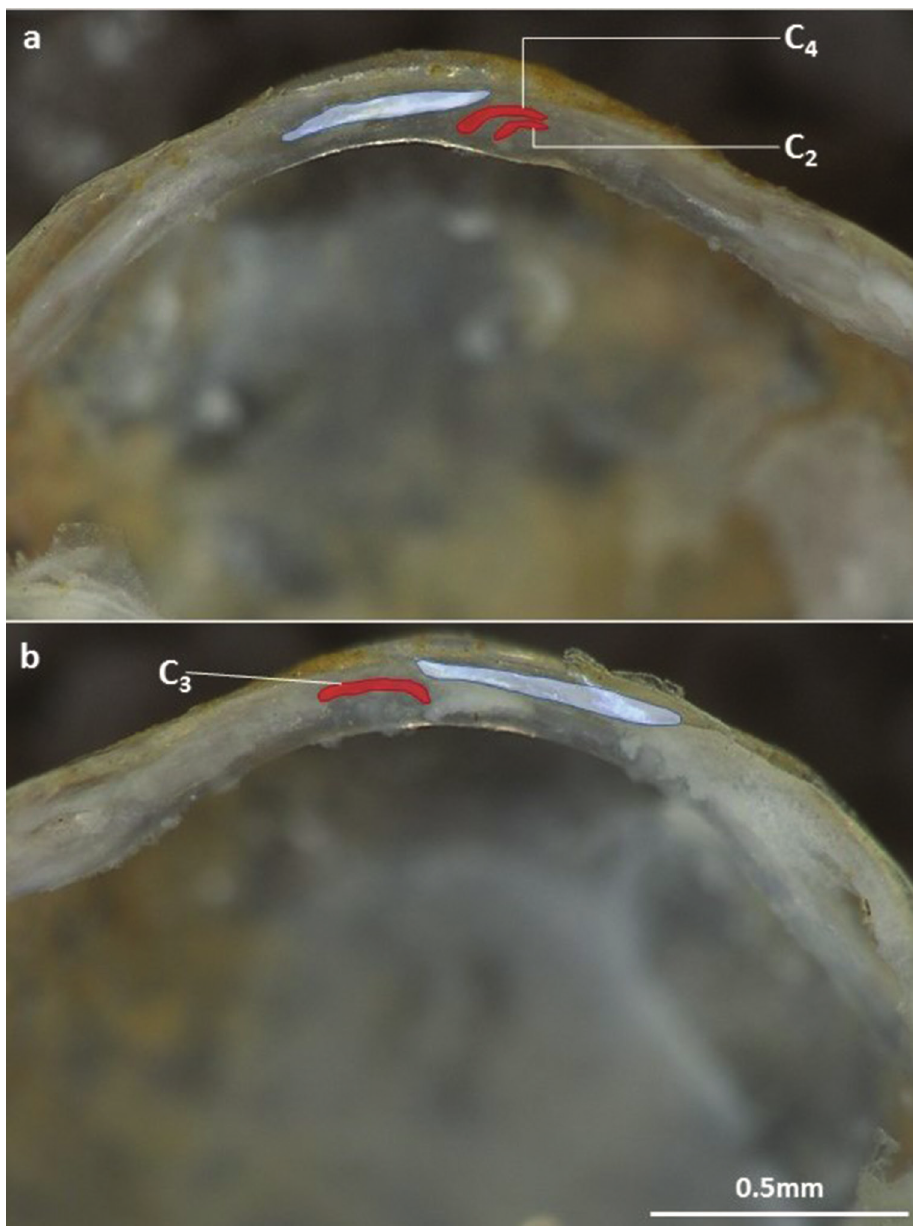
Figure 5. Position and shapes of cardinal teeth and ligament pits in left ( a ) and right valve ( b ). c: car- dinal